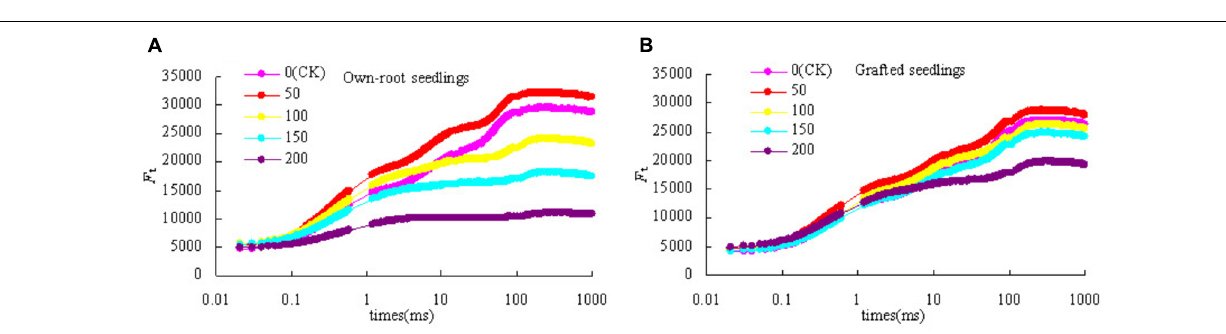
own-root seedlings, the difference was insignificant. As the salt concentration increased to 200 mmol L − 1 , the leaf N content decreased; and the leaf N content of grafted seedlings was